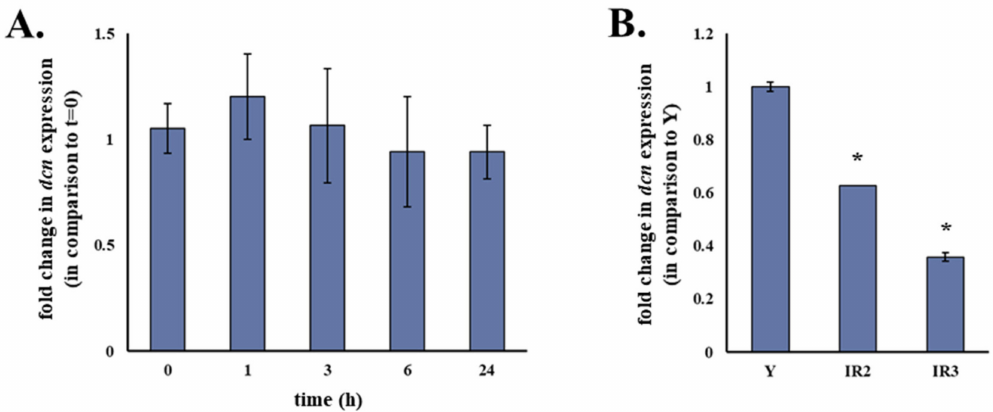
Figure 2. Decorin down-regulation in ionizing radiation-induced senescent human breast stromal fibroblasts seems to be a long-term response of the cells rather than an immediate effect of γ -irradiation. Confluent human breast stromal fibroblasts’ cultures in DMEM supplemented with 10% ( v / v ) FBS were exposed to 4 Gy of γ -irradiation and further incubated at 37 ◦ C for the designated time-points ( A ) or were exposed to 50 Gy of γ -irradiation and subjected to subculturing thrice ( B ) before RNA extraction. mRNA levels of decorin (dcn) were measured by real-time PCR following first-strand cDNA synthesis. Mean Ct values of dcn in each sample were normalized to that of glyceraldehyde-3-phosphate dehydrogenase (GAPDH). Ratios of the expression levels of treated cells to those of the respective untreated control are presented as mean values ± standard deviations of three independent experiments. Statistically significant differences (Student’s t test, p < 0.05) from Y are marked by asterisks (*). IR2: second subculture post-irradiation; IR3: third subculture